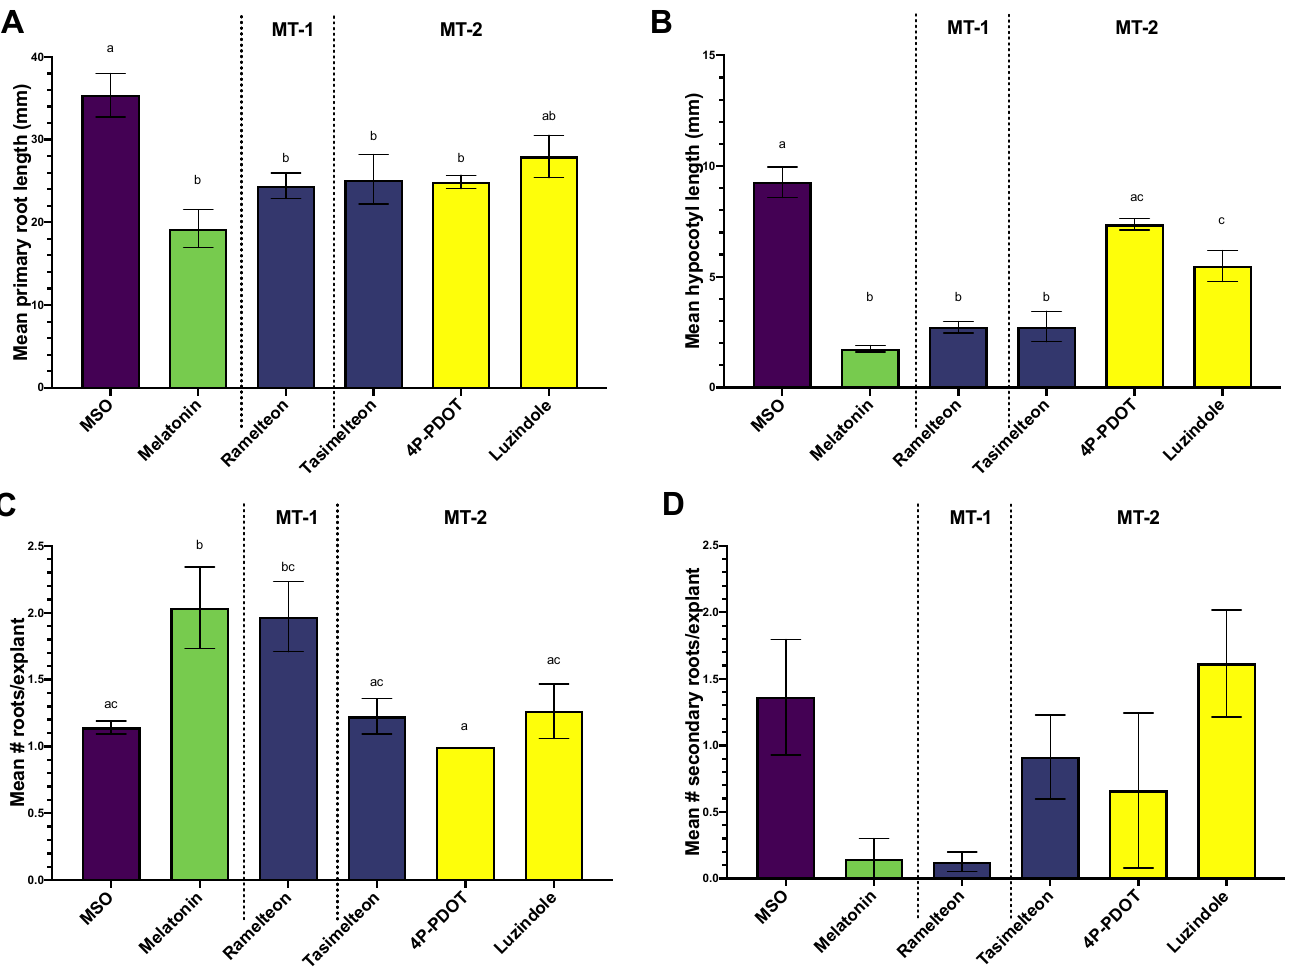
Figure 2. Growth effects of treatment with melatonin (100 µM) and melatonin agonists ramelteon (10 µM) and tasimelteon (10 µM) and antagonists luzindole (10 µM) and 4P-PDOT (10 µM) in Arabidopsis thaliana Col-0 ( A ) mean primary root length, ( B ) mean hypocotyl length, ( C ) mean number of primary roots/explants, ( D ) mean number of secondary roots/explants. Data are displayed as mean; error bars extend to the range of standard error. Different letters indicate significant difference between groups by ANOVA with Tukey’s honestly significant difference multiple comparisons model with alpha = 0.05. Where not shown, there was no significant difference between groups. MT-1 indicates compounds with higher affinity for the human MT-1 receptor subtype; MT-2 indicates compounds with higher affinity for the human MT-2 receptor subtype. Agonists have bars shaded in blue, whereas antagonists have yellow shaded bars.